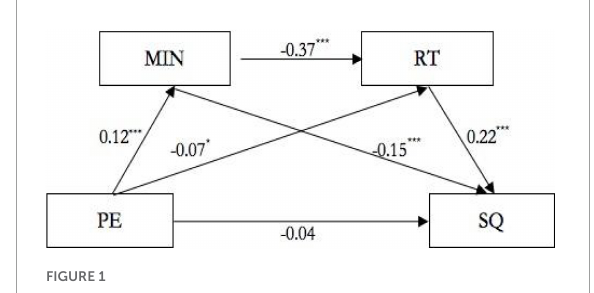
FIGURE1 Pathway map of PE affecting SQ. * p < 0.05, *** p <